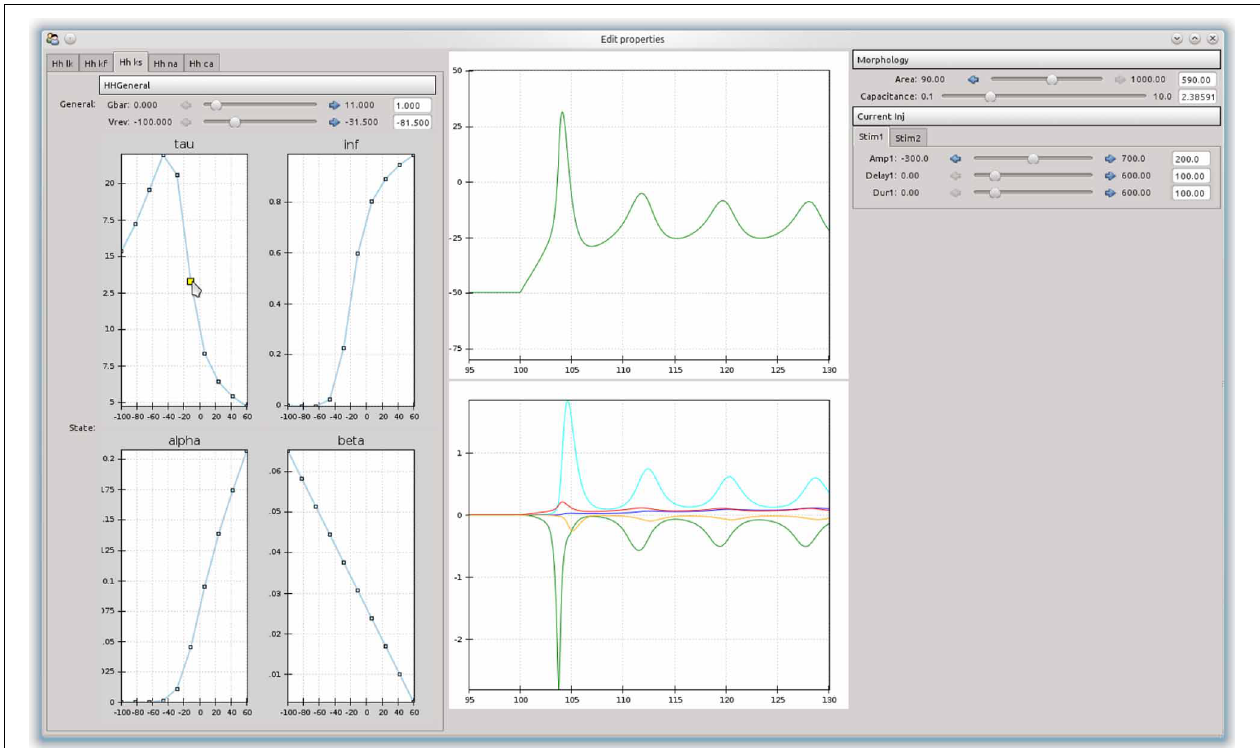
FIGURE 4 | A simple example of a graphical tool built on top of morphforge, which allows the effects of different parameters and rate-constant curves on the response of a neuron to step current injection to be interactively